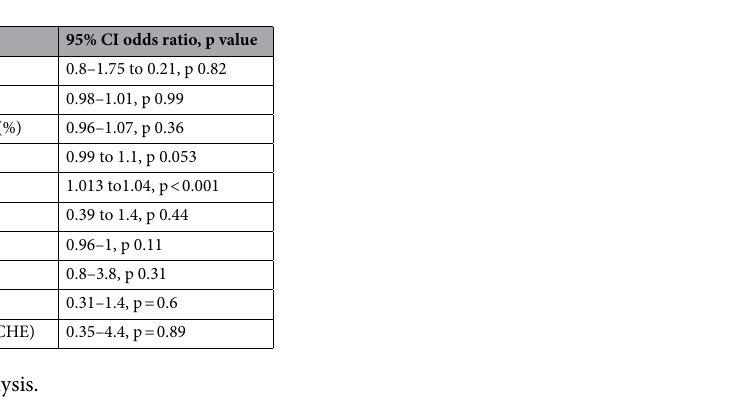
Table 3. Covariate